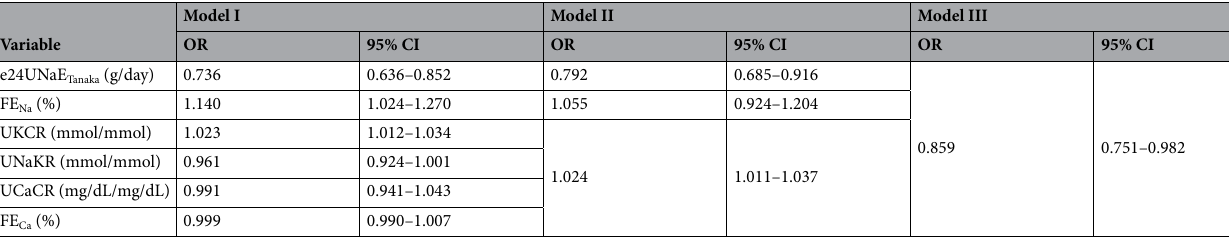
Table 3. Cox proportional-hazard model for osteoporosis*. *Defined as a bone mineral density T-score at distal radius or tibia shaft below −2.5. Model I, performed using age, sex, and smoking history as covariates. Model II, performed using age, sex, and smoking history as covariates and body mass index, waist circumference, systolic BP, diastolic BP, hemoglobin, sodium, corrected calcium, hemoglobin A1c, triglyceride, LDL-cholesterol, and UACR as predictors. Model III, performed using age, sex, and smoking history as covariates and body mass index, waist circumference, systolic BP, diastolic BP, hemoglobin, sodium, corrected calcium, hemoglobin A1c, triglyceride, LDL-cholesterol, UACR, and UKCR as predictors. HR, hazard ratio; CI, confidence interval.